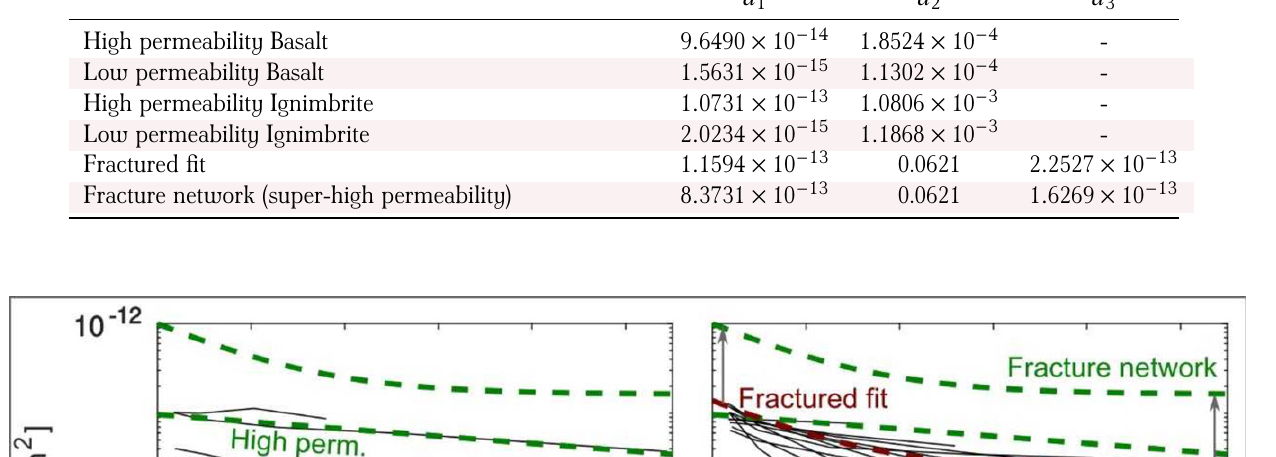
Table D1: Permeability functions derived from empirical values from Eggertsson et al. [2020] assuming hydrostatic conditions. Exponential function equation: 𝑘 ( 𝑧 ) = 𝑎